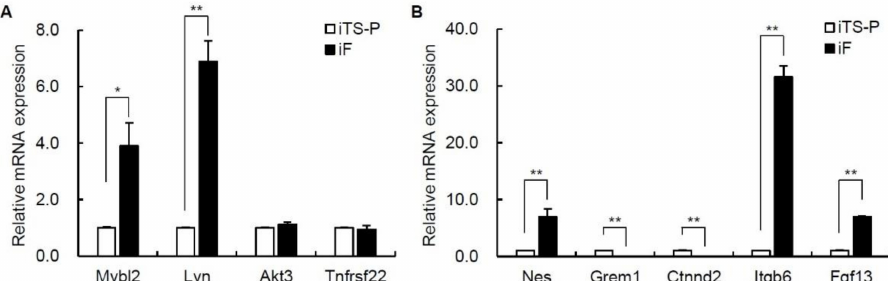
Figure 4. qRT-PCR analysis of oncogenes and intercellular adhesion markers in iF cells (passage 30) and iTS-P cells (passage 30). ( A ) iTS-P cells and iF cells were evaluated for oncogenes using qRT-PCR. ( B ) iTS-P cells and iF cells were evaluated for intracellular adhesion markers using qRT-PCR. The data are expressed as the gene-to-Gapdh ratio, with this ratio for iTS-P cells arbitrarily set to 1 ( n = 3). The error bars indicate the standard error values. * p < 0.05, ** p < 0.01.